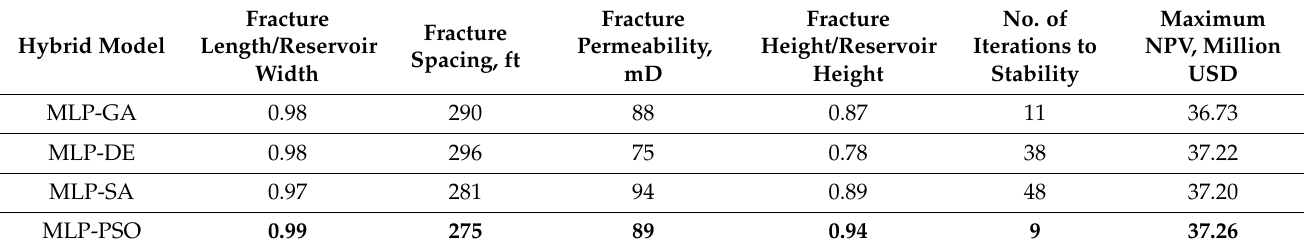
Table 7. Optimization results of different optimization